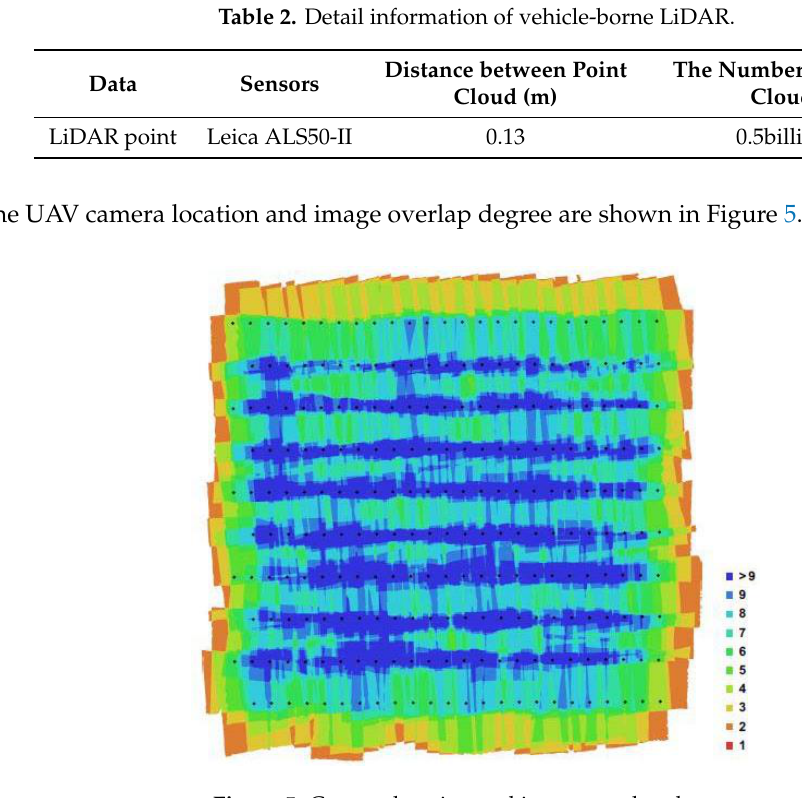
Figure 5. Camera location and image overlap degree.